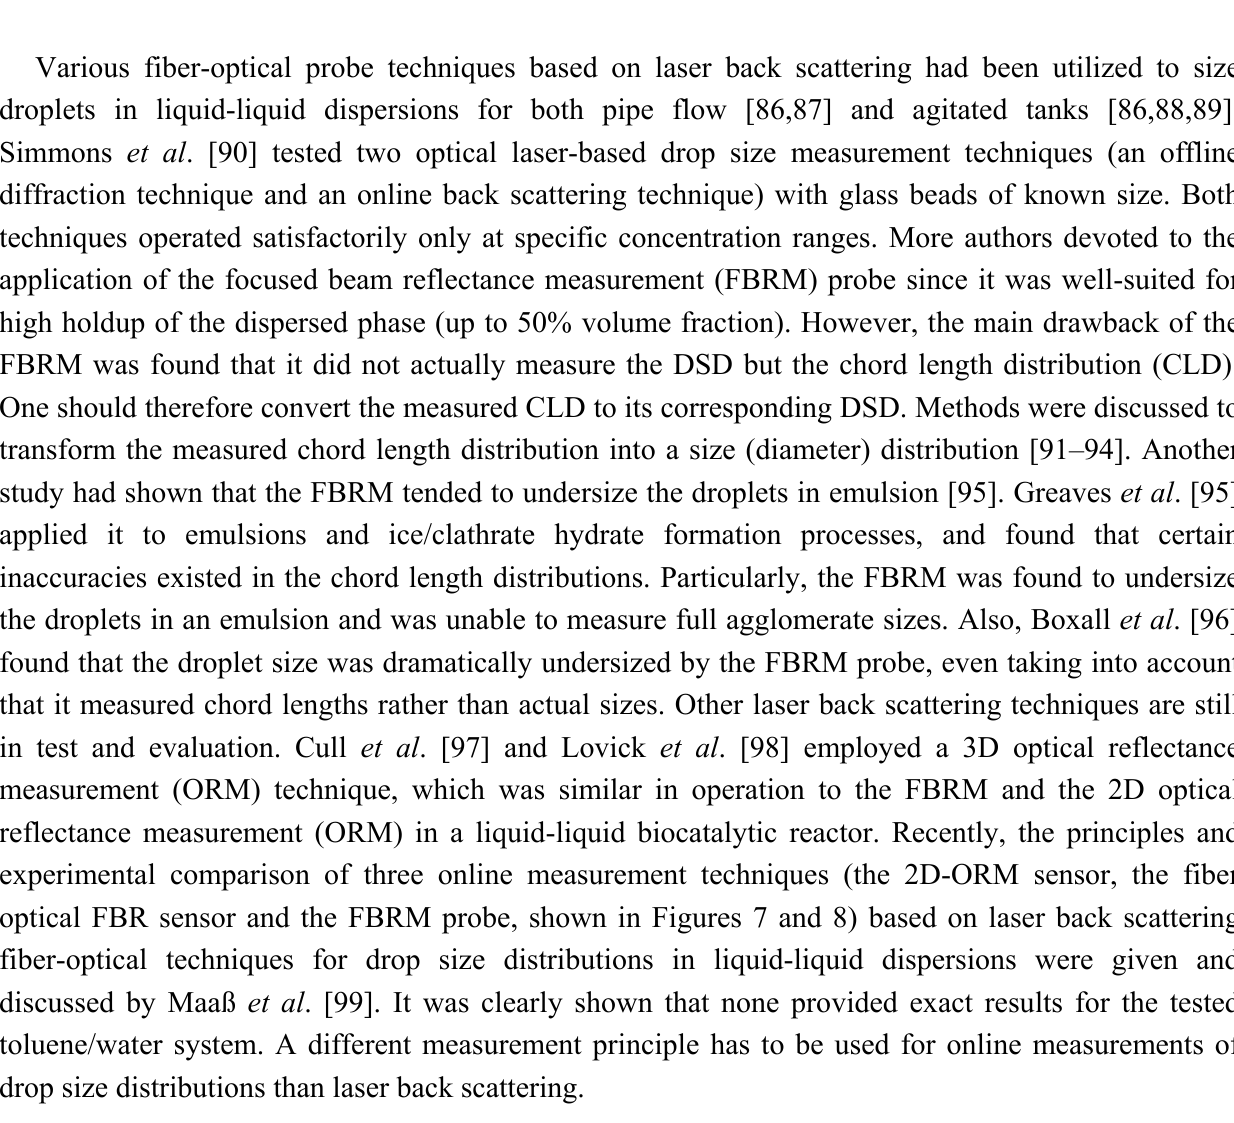
Figure 7. Droplet measurement set-up of the 2D-ORM sensor with 3D